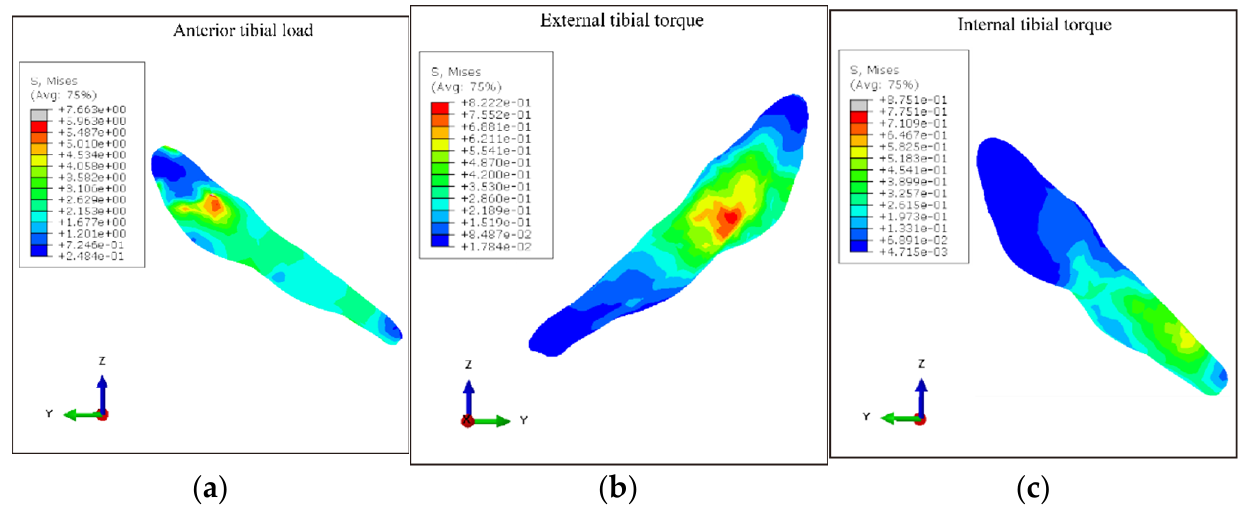
Figure 5. Stress distribution of the ACL: ( a ) ACL stress distribution under anterior tibial load; ( b ) ACL stress distribution under external tibial torque; ( c ) ACL stress distribution under internal tibial torque.